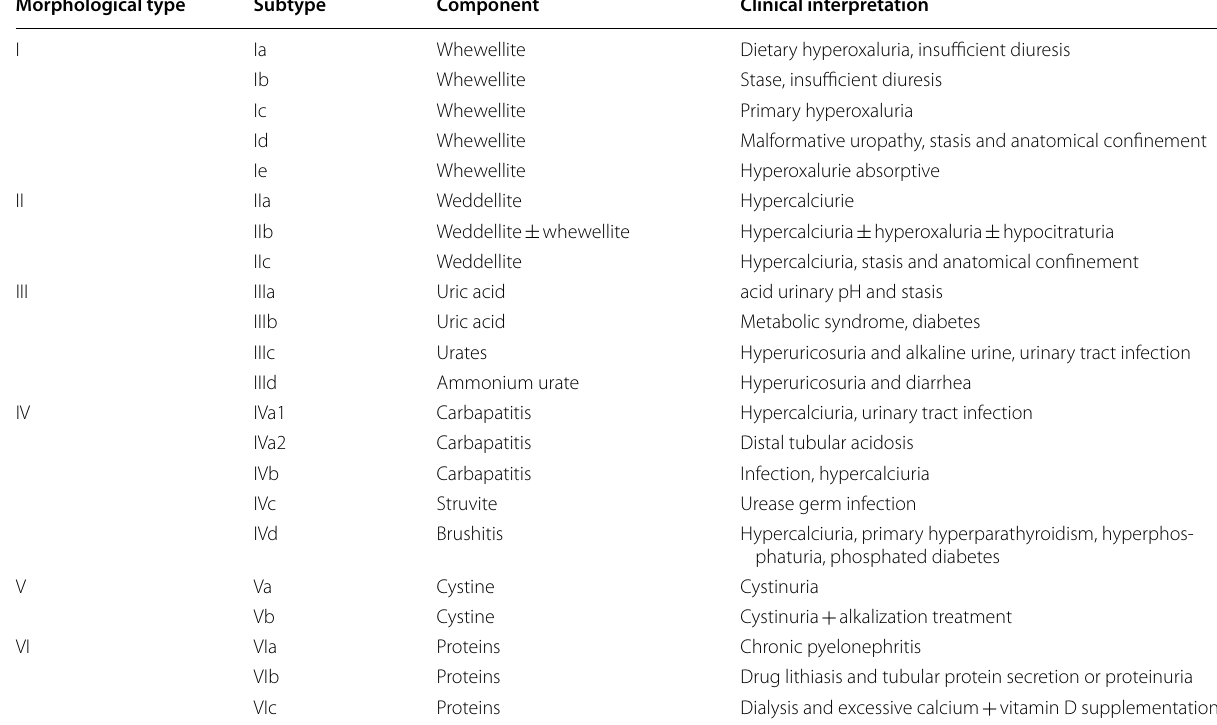
Table 1 Morpho‑constitutional classification of the stones according to Daudon et al. Morphological